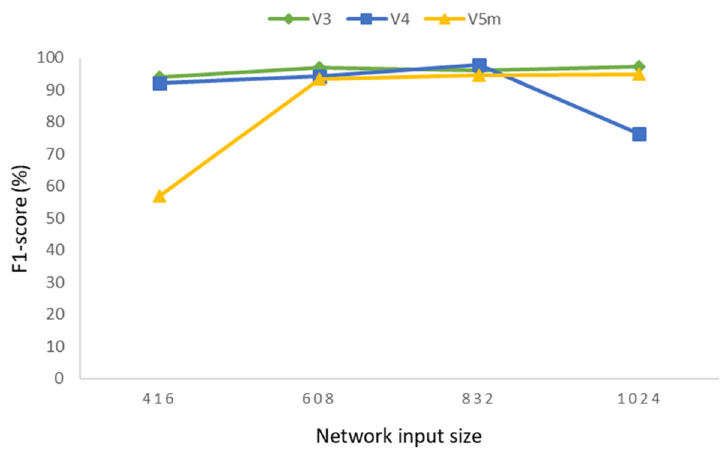
Figure 11. Comparison of the F1-score values of YOLOv3, YOLOv4, and YOLOv5m.